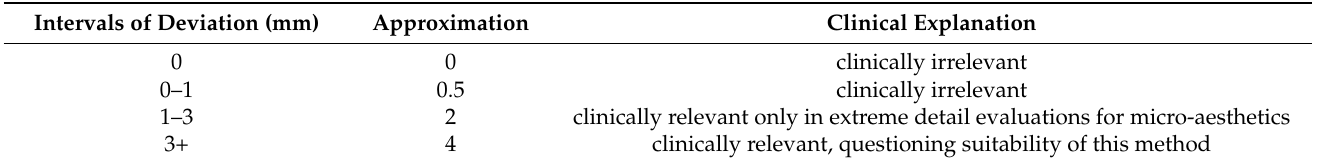
Table 1. Clinical evaluation of amount of deviation between CBCT and 3D TrueDepth (Bellus3D Dental Pro)